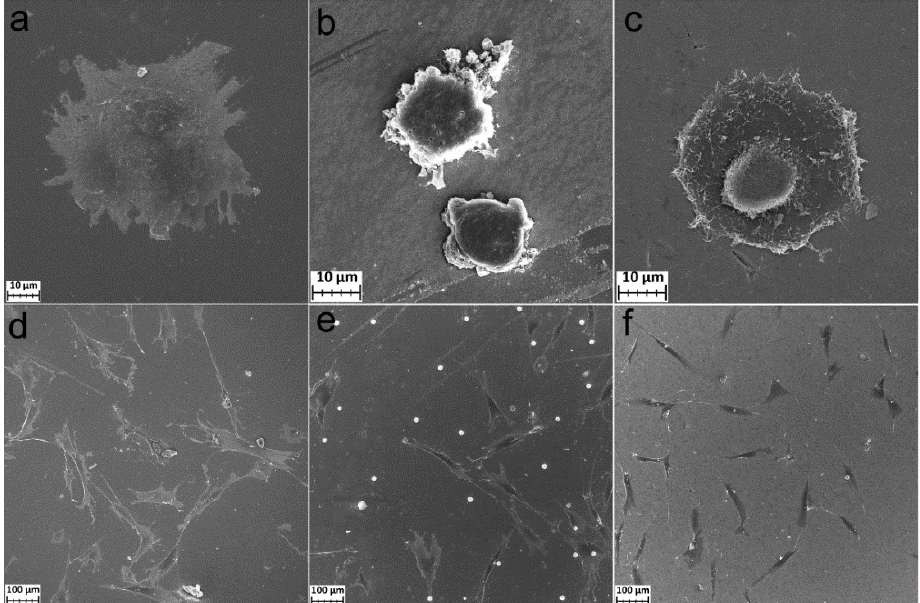
Figure 9. SEM images of FetMSC cells incubated during 2 h on Ti ( a ), Ti-TiO 2 (TiCl 4 /H 2 O) ( b ), and Ti-TiO 2 (TTIP/H 2 O) ( c ) samples and incubated during 24 h on Ti ( d ), Ti-TiO 2 (TiCl 4 /H 2 O) ( e ), and Ti-TiO 2 (TTIP/H 2 O) ( f ) samples.